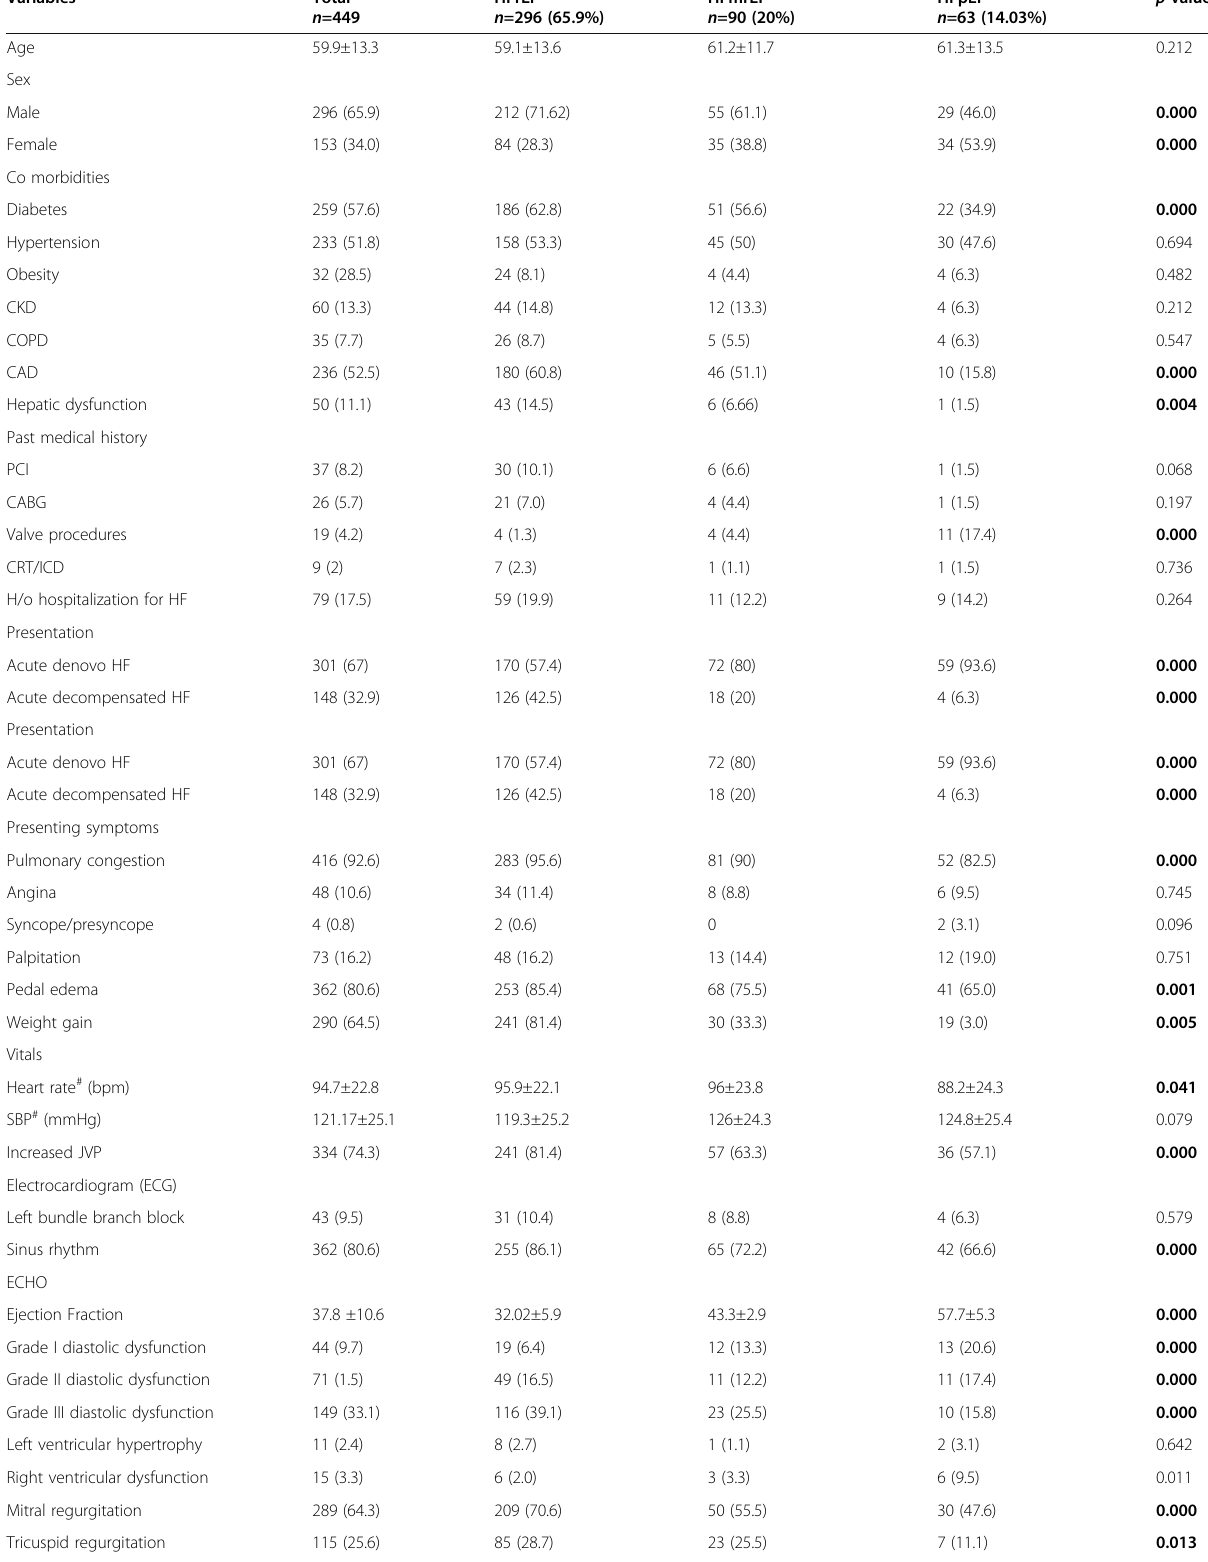
Table 1 Baseline characteristics of patients admitted with heart